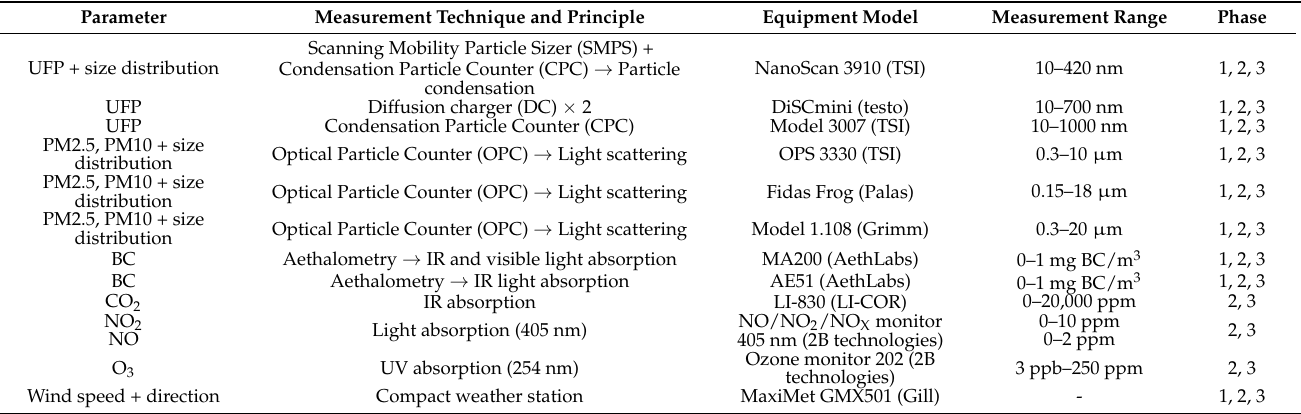
Table 2. Information regarding air pollutant and meteorological devices.